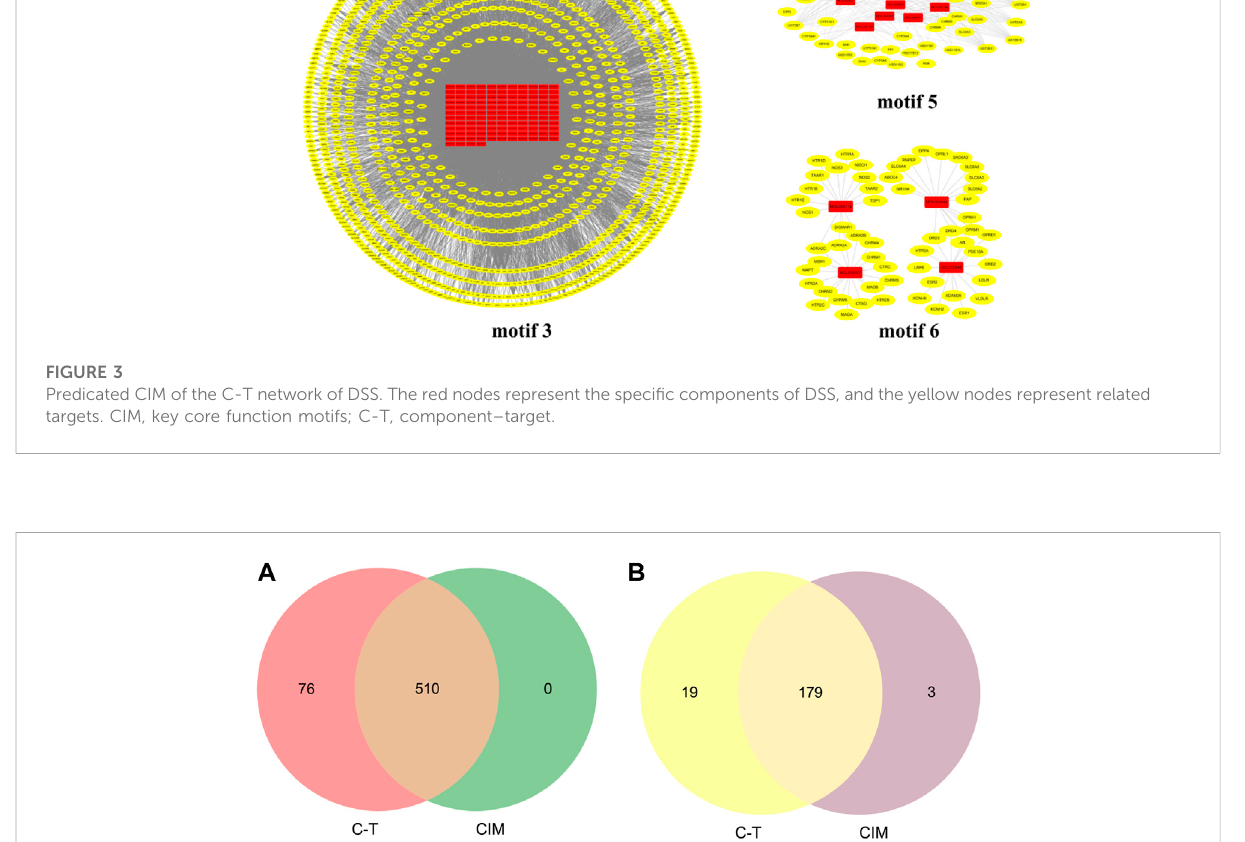
Frontiers in Cell and Developmental